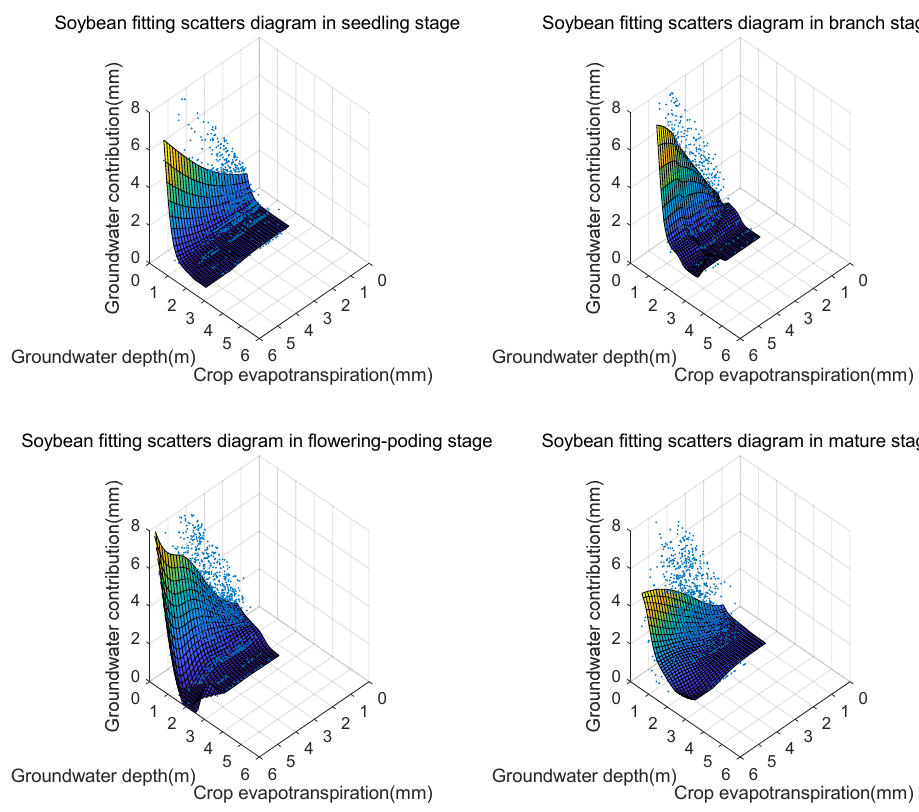
Figure 7. Fitting scatter diagrams for groundwater depth, crop evapotranspiration, and groundwater contribution in each growth period for soybeans using the machine learning method.